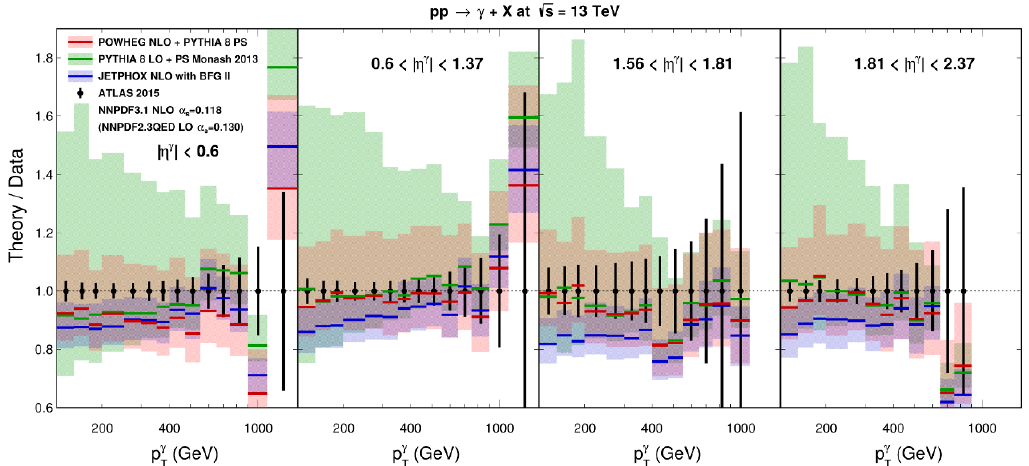
Figure 3 . Same as (cid:12)gure 2, but with theory normalised to data and including scale uncertainties.